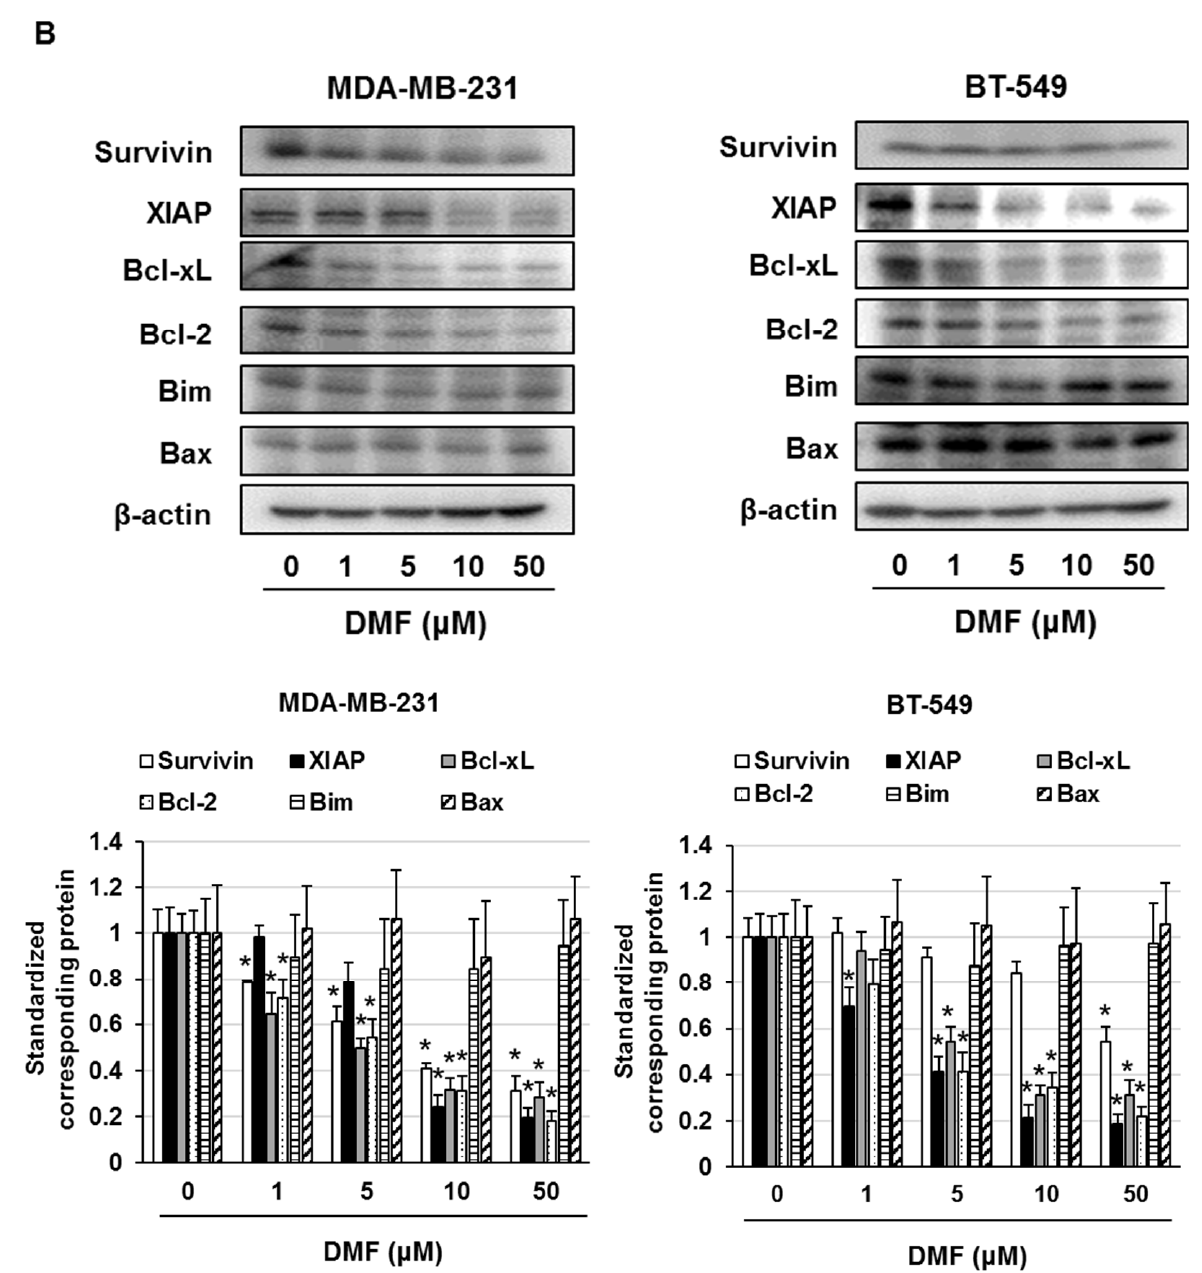
Figure 4. DMF suppressed NF- κ B nuclear translocation and Survivin, XIAP, Bcl-xL, and Bcl-2 expression in MDA-MB-231 and BT-549 cells. ( A ) Cell lysates were evaluated by immunoblotting using the shown antibodies. The contents of nuclear NF- κ B p65, cytoplasmic NF- κ B p65, phospho- JNK, phospho-p38MAPK, phospho-ERK1/2, and phospho-Akt were quantified and standardized to the contents of Lamin A/C, β -actin, JNK, p38MAPK, ERK1/2, or AKT. The results are exemplary of three independent experiments. * p < 0.01 vs. untreated cells. ( B ) Cell lysates were evaluated by immunoblotting using the shown antibodies. The contents of Survivin, XIAP, Bcl-xL, Bcl-2, Bim, and Bax were quantified and standardized to the content of β -actin. The results are exemplary of three independent experiments. * p < 0.01 vs. untreated